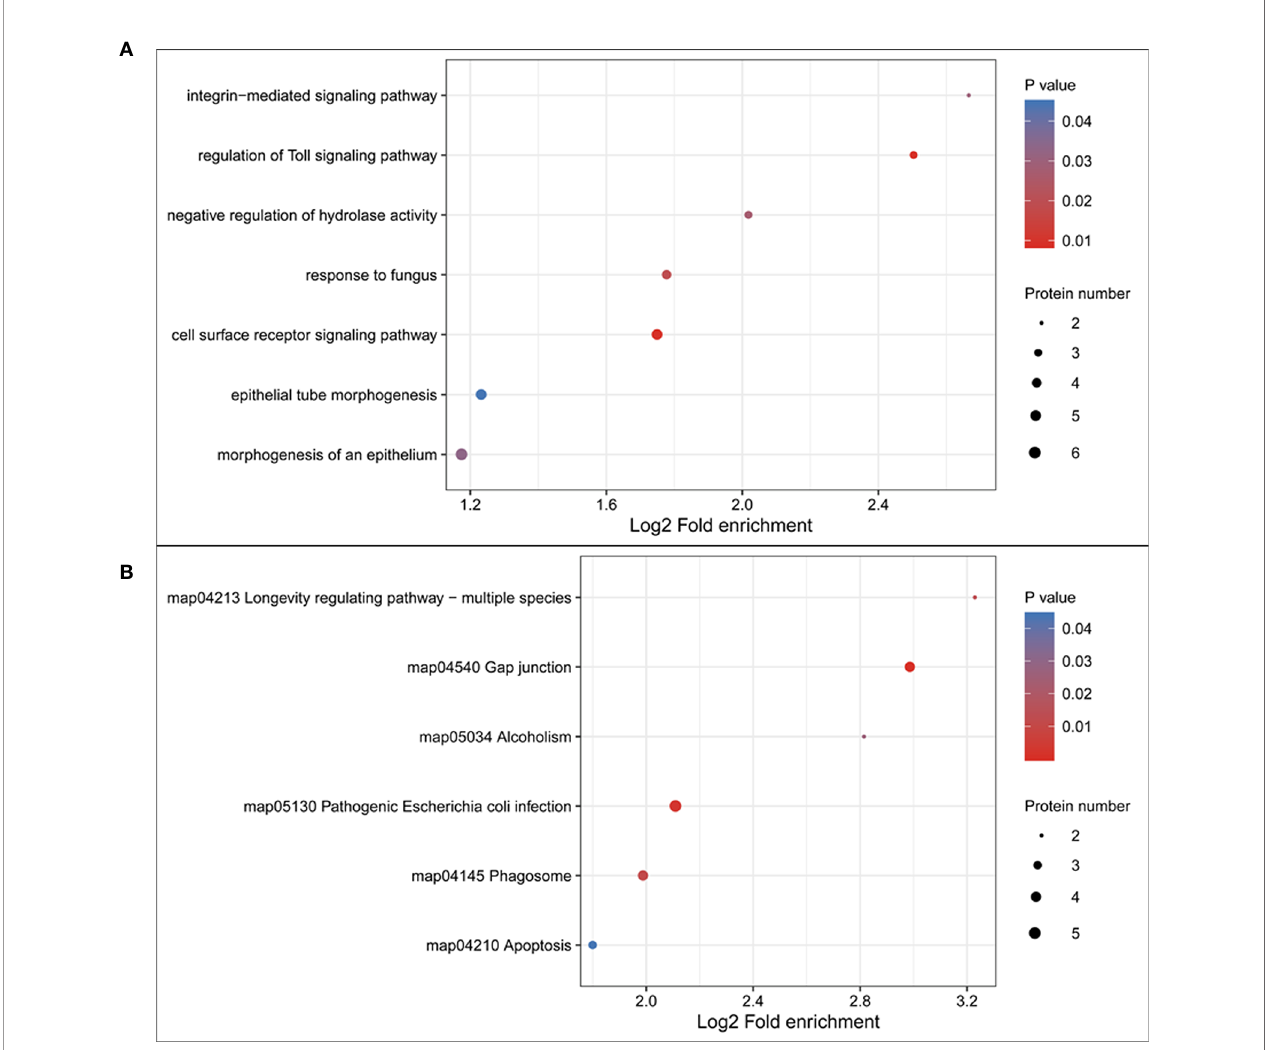
FIGURE 4 | Gene ontology (GO) and KEGG pathway enrichment of the differentially expressed proteins. (A) GO pathway enrichment of differentially expressed proteins; (B) KEGG pathway enrichment of upregulated